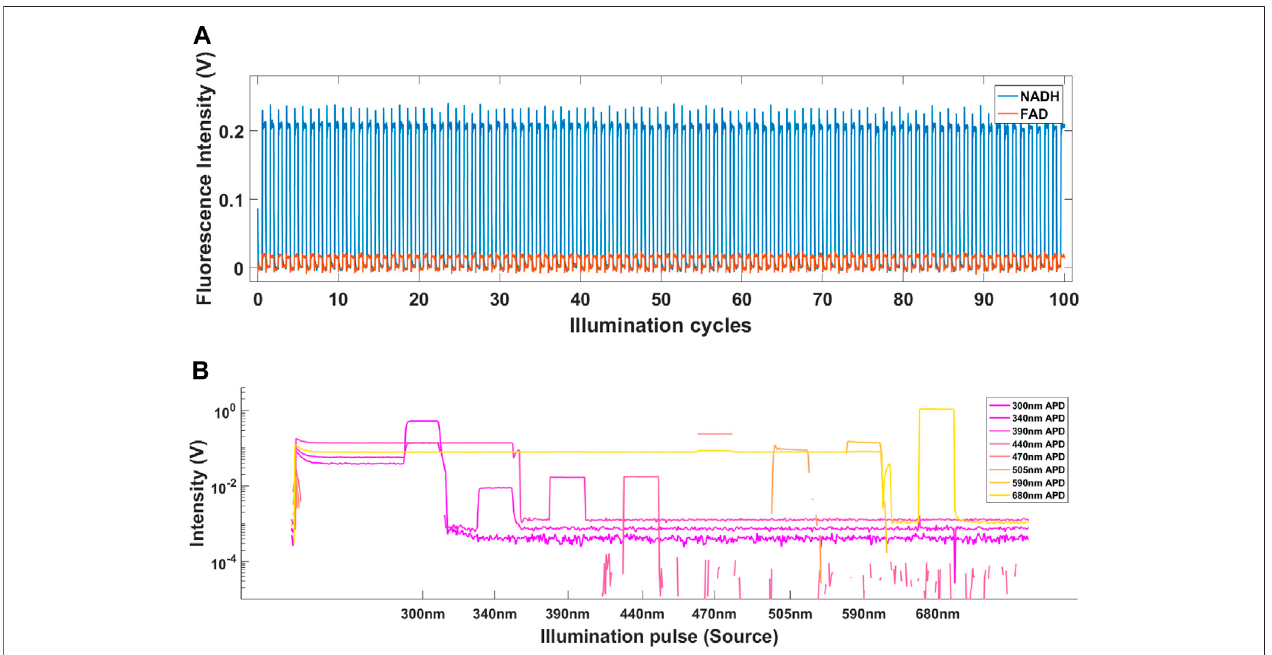
FIGURE 3 | (A) The fl uorescence intensity of NADH (blue) and FAD (red) in response to 100 illumination pulses from 340 to 470 nm sources measured in 440 and 505 nm channels, respectively. (B) Raw signal recorded from gray matter of sheep brain. The signal includes ambient background as well as positive and negative DC offsets caused by high ampli fi er gain.